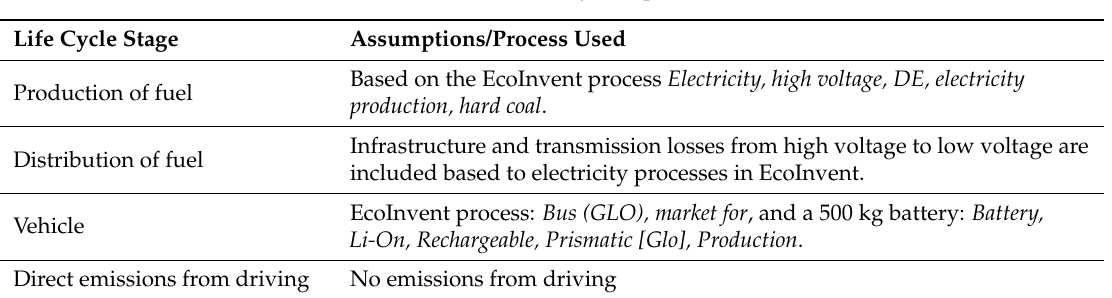
Table A5. Electricity coal